Question: What style of plot is this figure drawn as?
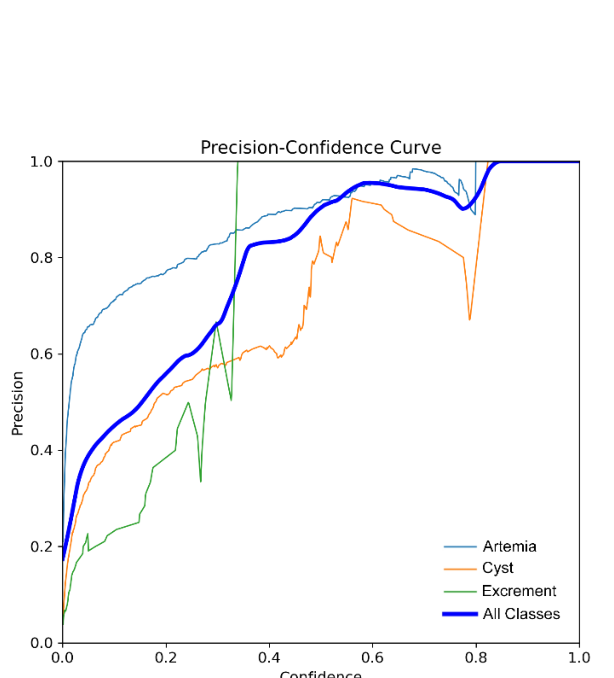
Answer: line